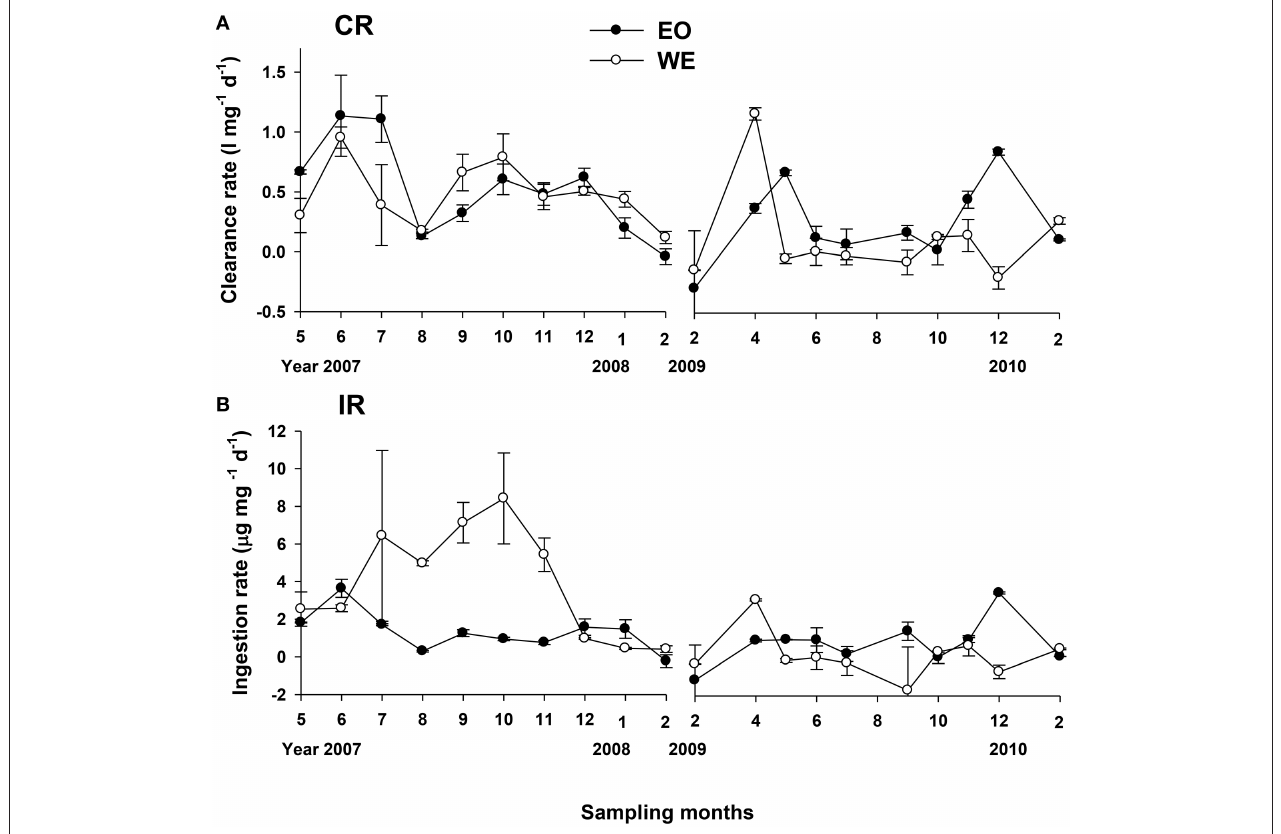
FIGURE 7 | Temporal variation in mesozooplankton (A) clearance rates (CR) and (B) ingestion rates (IR) on total phytoplankton.